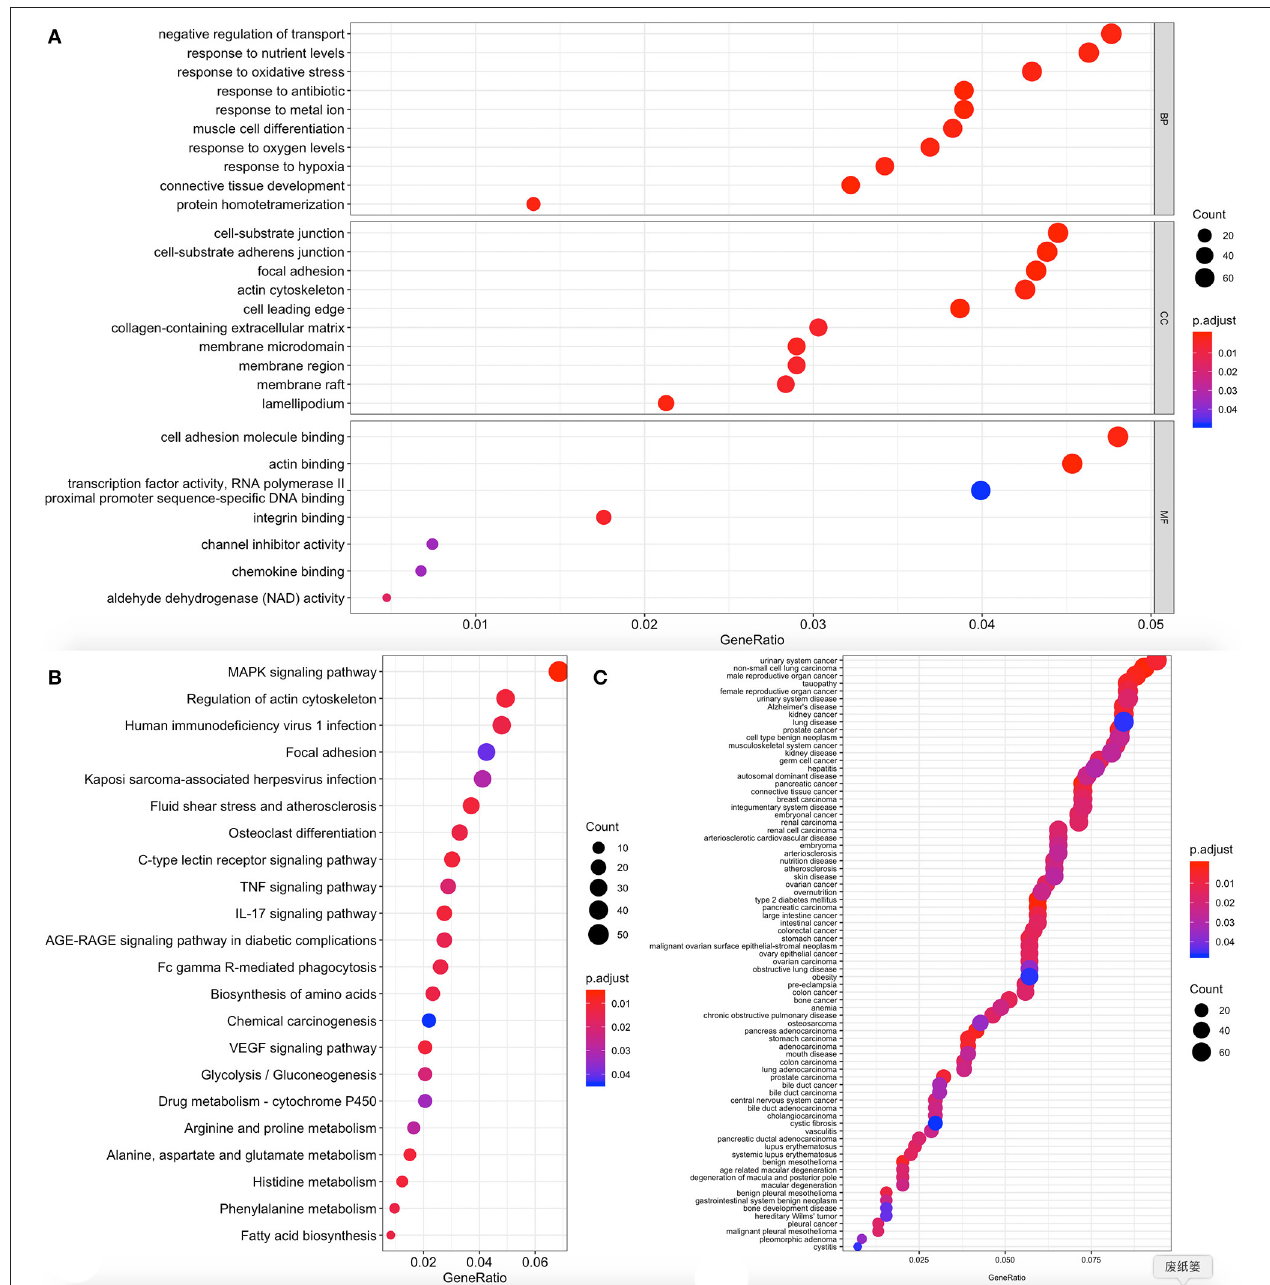
FIGURE 5 | Functional enrichment of differentially expressed genes (DEGs). The x-axis shows the ratio number of genes and the y-axis shows the pathway terms. The -log10 ( P value) of each term is colored according to the legend. (A) Gene Ontology; (B) Kyoto Encyclopedia of Genes and Genomes (KEGG) pathway analysis; (C) Disease